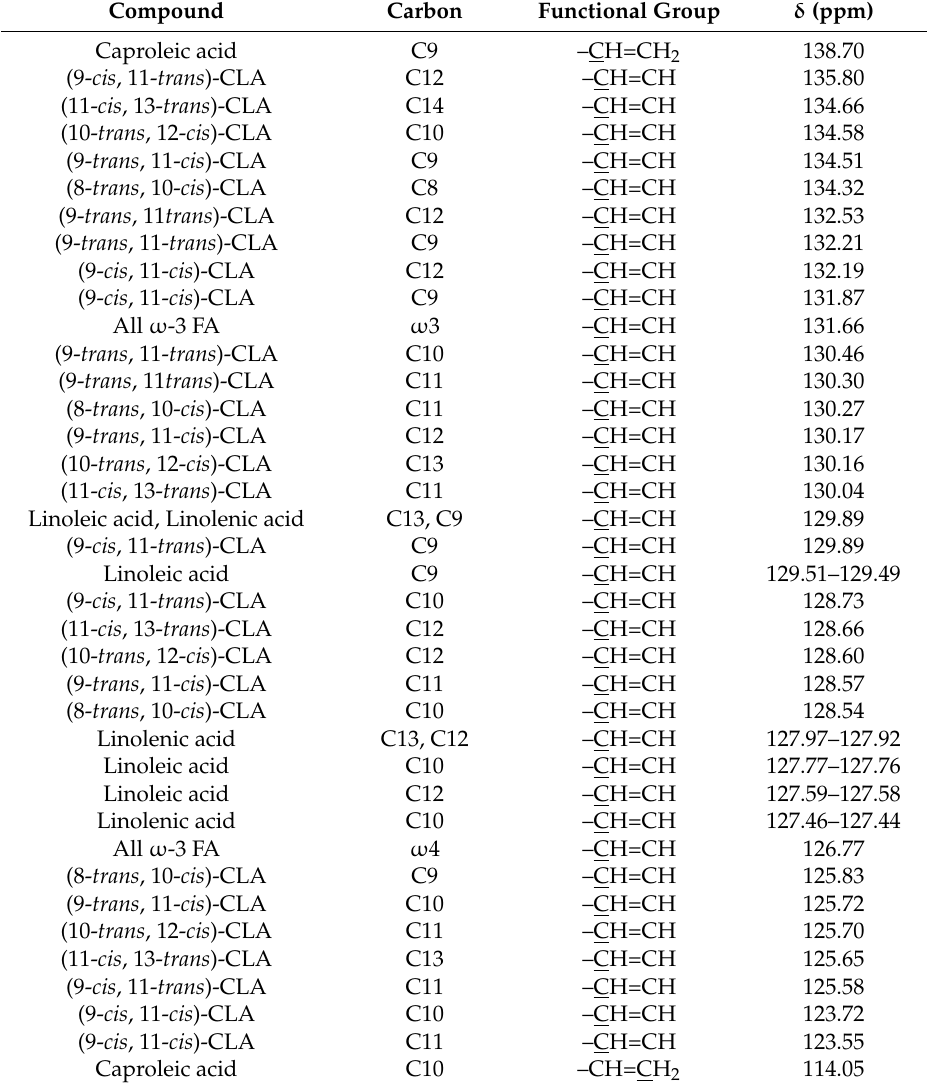
Table 13. 13 C-NMR peak assignments of the olefinic carbons of some representative UFAs in CDCl 3 . Compound